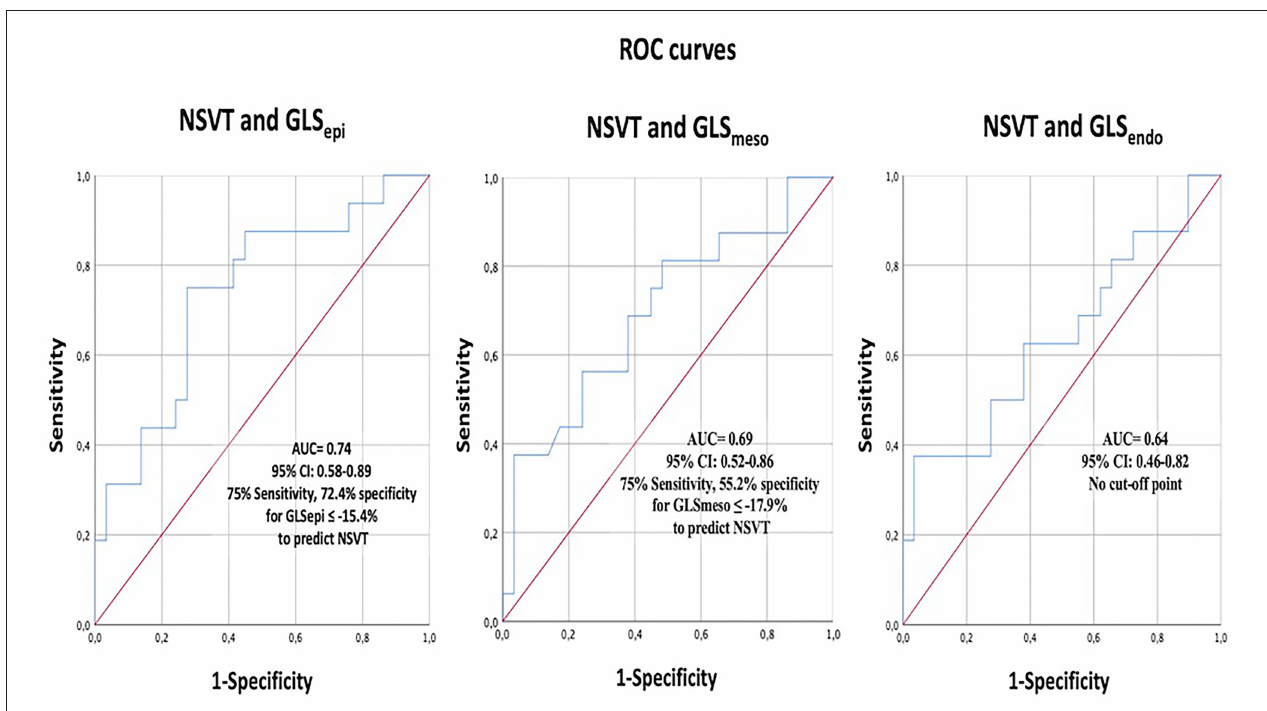
FIGURE 3 | The receiver operating characteristics (ROC) curve analysis of layer-specific GLS to predict NSVT. GLS, global longitudinal strain; NSVT, non-sustained ventricular